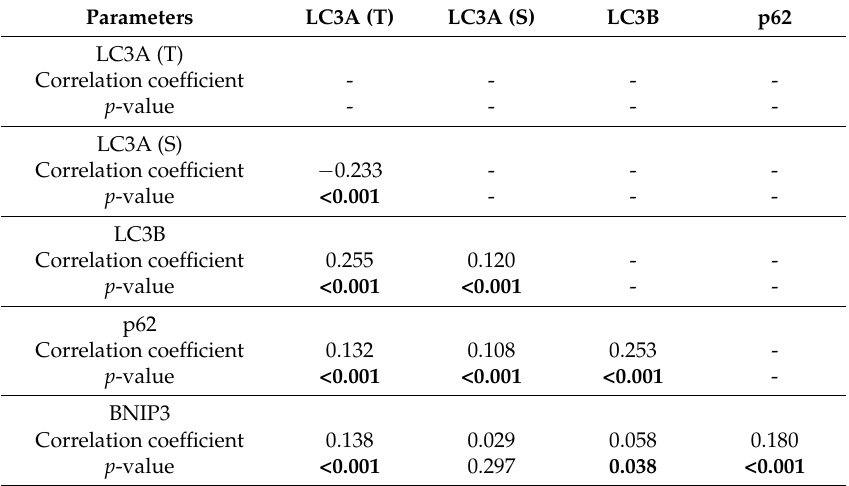
Table 5. Correlation among the expressions of autophagy-related